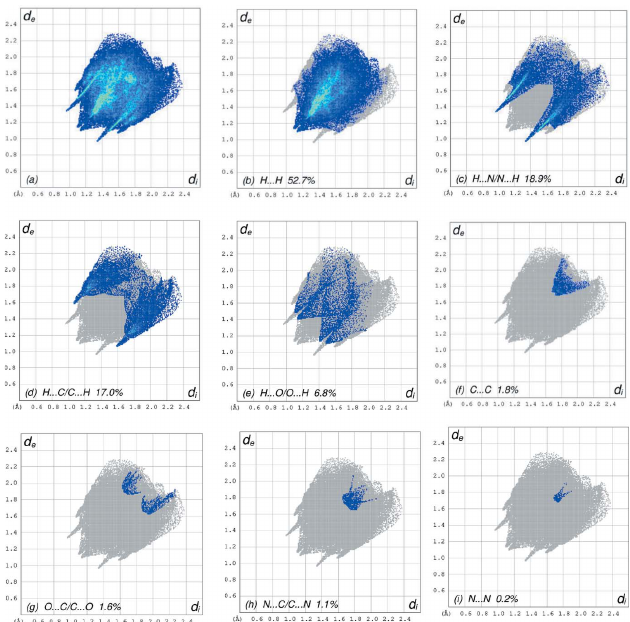
Figure 6 The full two-dimensional fingerprint plots for the title compound, showing ( a ) all interactions, and delineated into ( b ) H (cid:3)(cid:3)(cid:3) H, ( c ) H (cid:3)(cid:3)(cid:3) N/ N (cid:3)(cid:3)(cid:3) H, ( d ) H (cid:3)(cid:3)(cid:3) C/C (cid:3)(cid:3)(cid:3) H, ( e ) H (cid:3)(cid:3)(cid:3) O/O (cid:3)(cid:3)(cid:3) H, ( f ) C (cid:3)(cid:3)(cid:3) C, ( g ) O (cid:3)(cid:3)(cid:3) C/C (cid:3)(cid:3)(cid:3) O, ( h ) N (cid:3)(cid:3)(cid:3) C/C (cid:3)(cid:3)(cid:3) N and ( i ) N (cid:3)(cid:3)(cid:3) N interactions. The d i and d e values are the closest internal and external distances (in A˚ ) from given points on the Hirshfeld surface contacts.